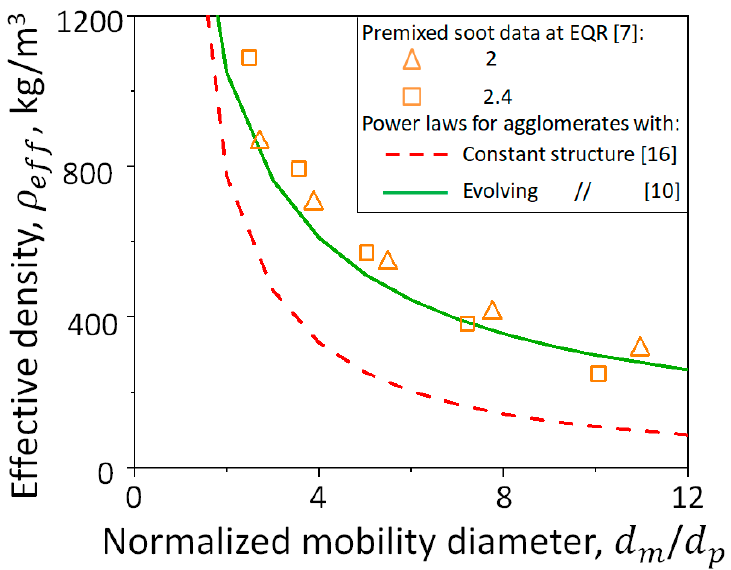
Figure 6. Evolution of agglomerate effective density, ρ ef f , as a function of their normalized mobility diameter, d m / d p , measured for soot particles sampled from premixed ethylene flames with equiva- lence ratios of 2 (triangles) or 2.4 (squares) and estimated assuming constant (broken line) or evolving agglomerate structure (solid